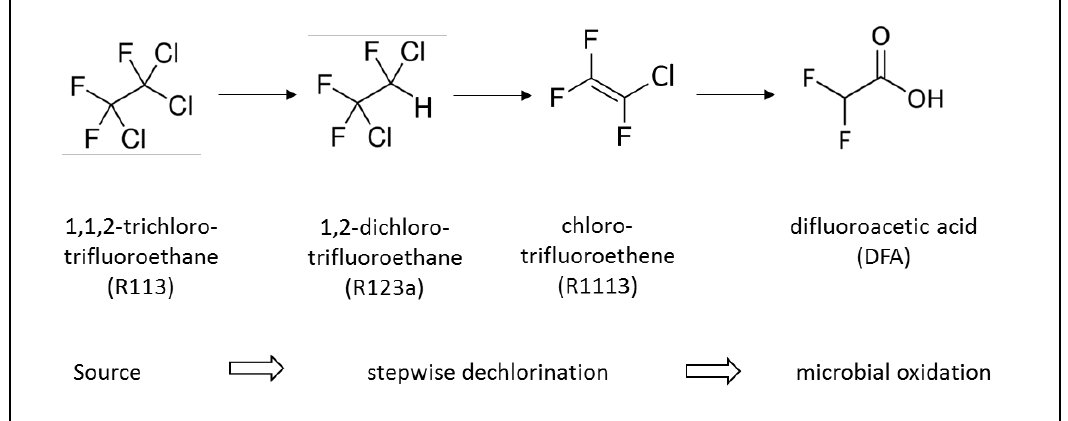
Table 2. Concentration of TFA, DFA, and chlorofluorocarbons (CFCs) in the ground water samples, means and relative standard deviations (TFA and DFA: n = 2; CFCs: n = 6). R113: 1,1,2-trichloro-1,2,2-